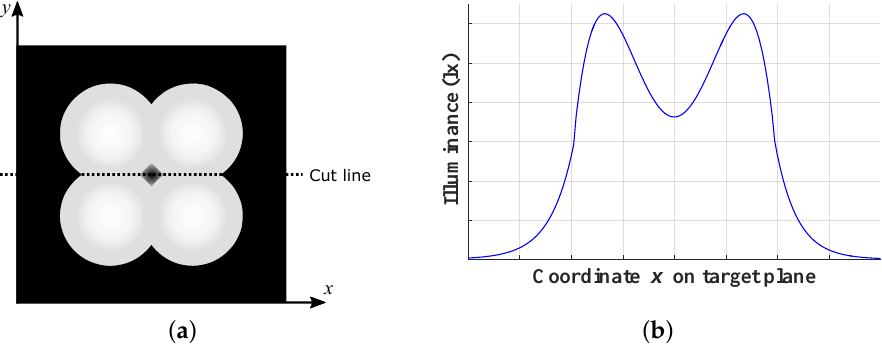
Figure 8. Hypothetical illustration of a luminaire with four LEDs: ( a ) HP-LED radiation pattern on the target plane and ( b ) values of illuminance on the cut line on the x axis.